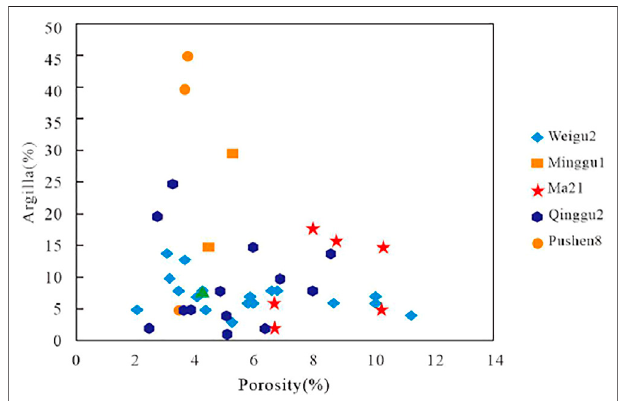
FIGURE 13 | Relationships between the porosity levels and argilla content levels of the Upper Paleozoic reservoirs in the Dongpu Depression.